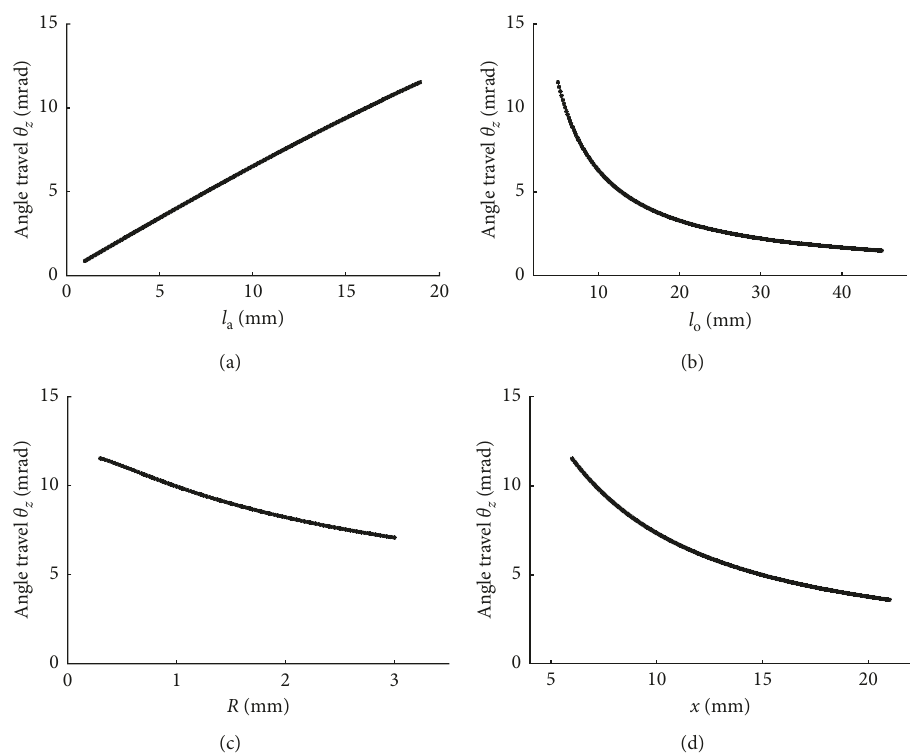
z on the design parameters: (a) l a ; (b) l o ; (c) R ; (d) x .